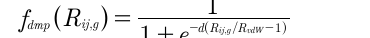
Figure 1. The unit cell and zigzag chain of α-PbO labels are numbered for later